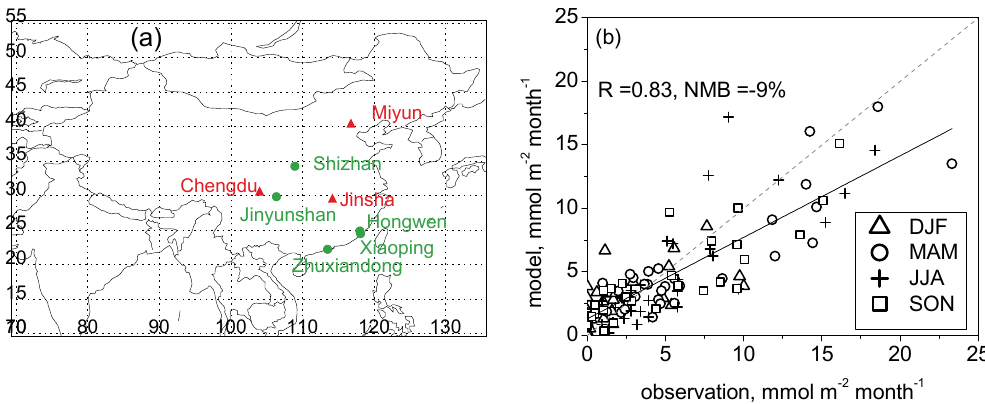
Figure 2. (a) Locations of observation sites. The red triangles represent sites with surface sulfate concentration, and the green dots represent sites with sulfate wet deposition fluxes. (b) Scatter plot of simulated vs. observed sulfate wet deposition fluxes in five sites over China, from January 2009 to December